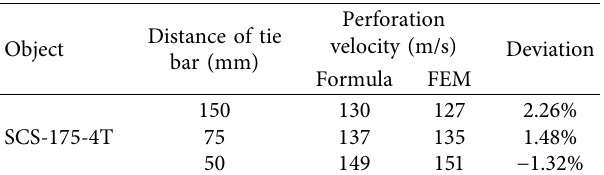
Table 4: Perforation velocity comparison of SCS-175-4T with a different distance of tie bar for the blunt projectile.